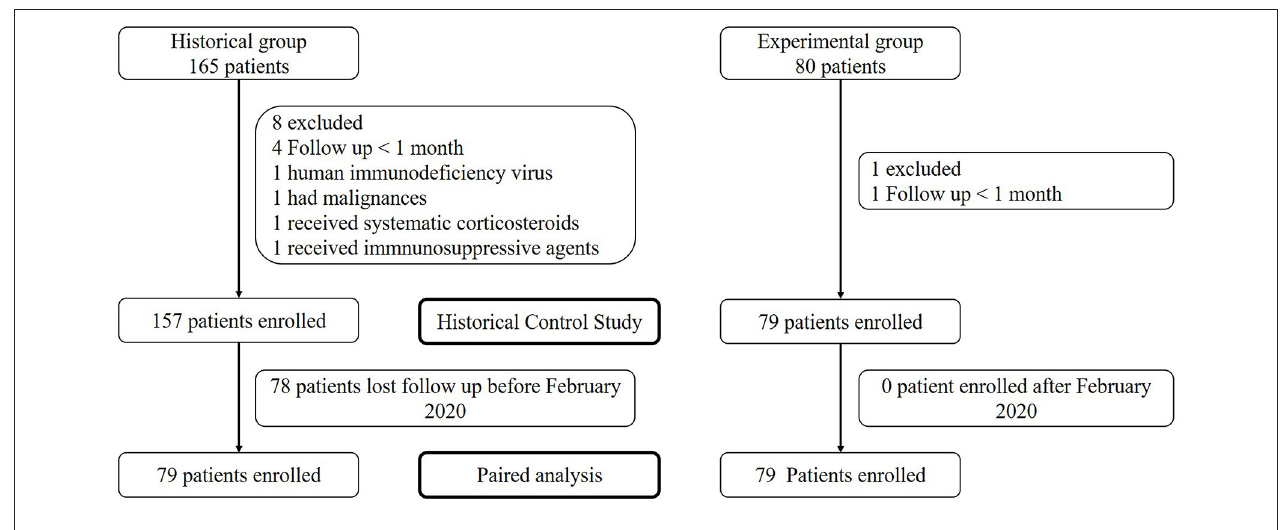
FIGURE 1 | Patient flow diagram.